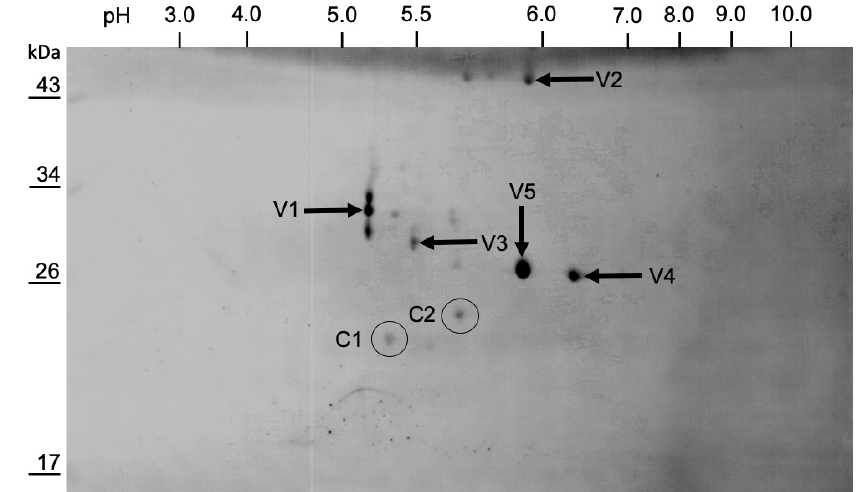
Figure 6. Two-dimensional gel electrophoresis of purified La Jolla virus (LJV) virions. Isoelectric focusing in the pH range 3.0 to 10.0 was followed by SDS-PAGE in a 12.5% polyacrylamide gel and blotting onto a PVDV membrane. The stained protein spots (shown here in grayscale for contrast enhancement) were picked from the membrane for Edmann degradation and peptide mass fingerprinting. The spots labeled V1–V5 are viral proteins and those labeled C1 and C2 are contaminating cellular proteins. Spots V1, V2 and V3 were assigned to VP1 (spot V1 also contains VP3). V4 and V5 were assigned to VP2. The horizontal axis of the membrane indicates pH and the vertical axis indicates molecular size